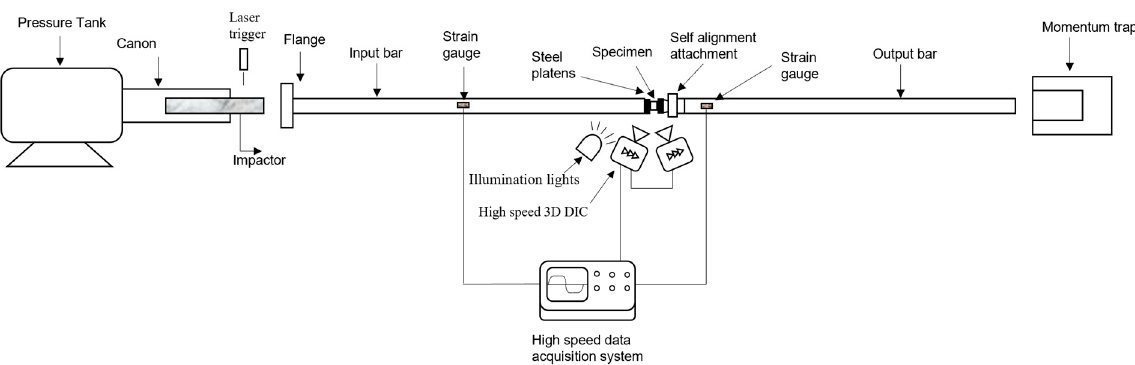
Figure 4. Schematic of the SHPB setup.